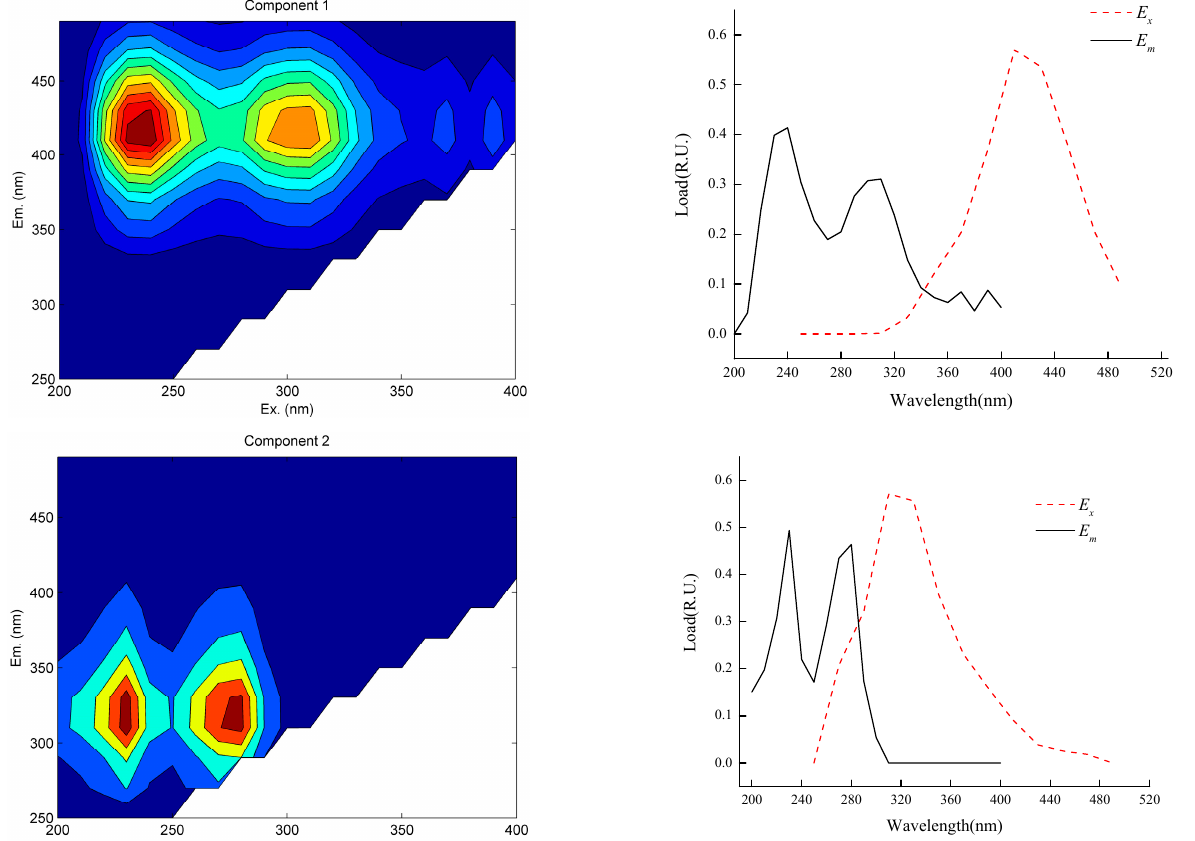
Figure 8. DOM characteristics of effluent at the Caojiatan mine water treatment station. This is because the protein tyrosine-like fluorescence is composed of several simple molecular structures, such as amino proteases and peptides, with fluorescent groups. Tryptophan is used to represent fatty hydrocarbons and alkanes with relatively simple molecular structures, and so it easily degrades [49–51] under the coagulation–filtration– disinfection treatment (Figure 9).